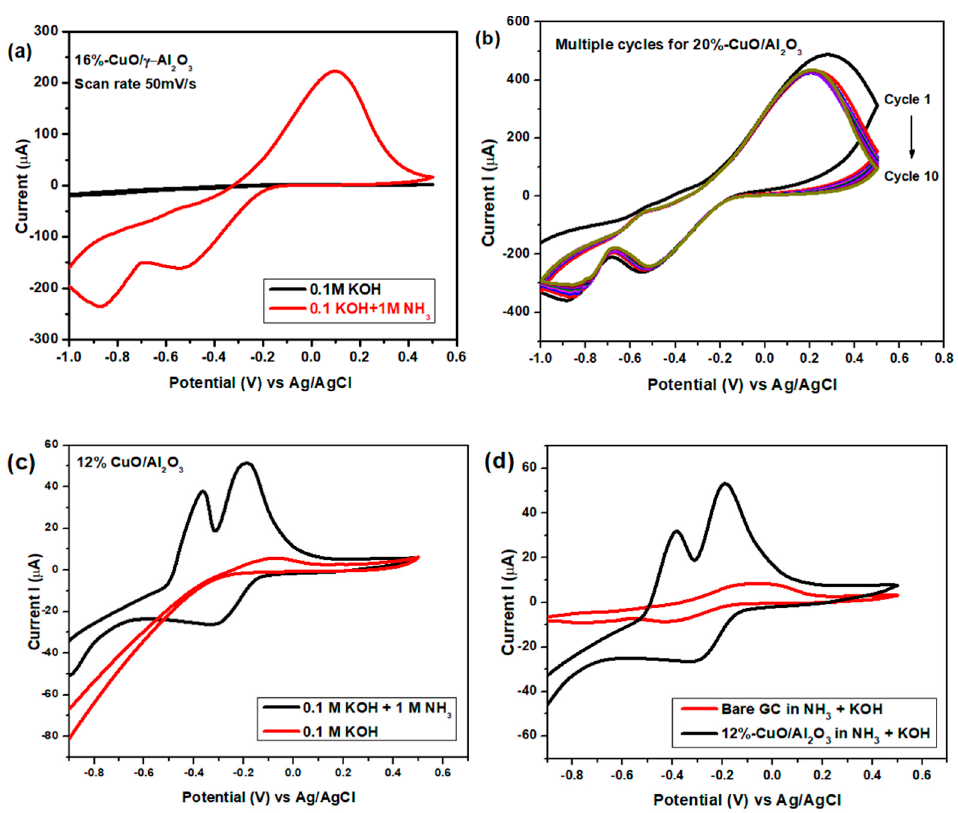
Figure 8. Comparison of CV curves for 16%-CuO/ γ -Al 2 O 3 recorded pure 0.1 M KOH and solution of 1.0 M NH 3 in 0.1 M KOH ( a ), Multiple cycles for 20%-CuO/ γ -Al 2 O 3 ( b ), Comparison of NH 3 free voltammetry for 12%-CuO/ γ -Al 2 O 3 ( c ) and Comparison of 12%-CuO/ γ -Al 2 O 3 with bare glassy carbon electrode ( d ).